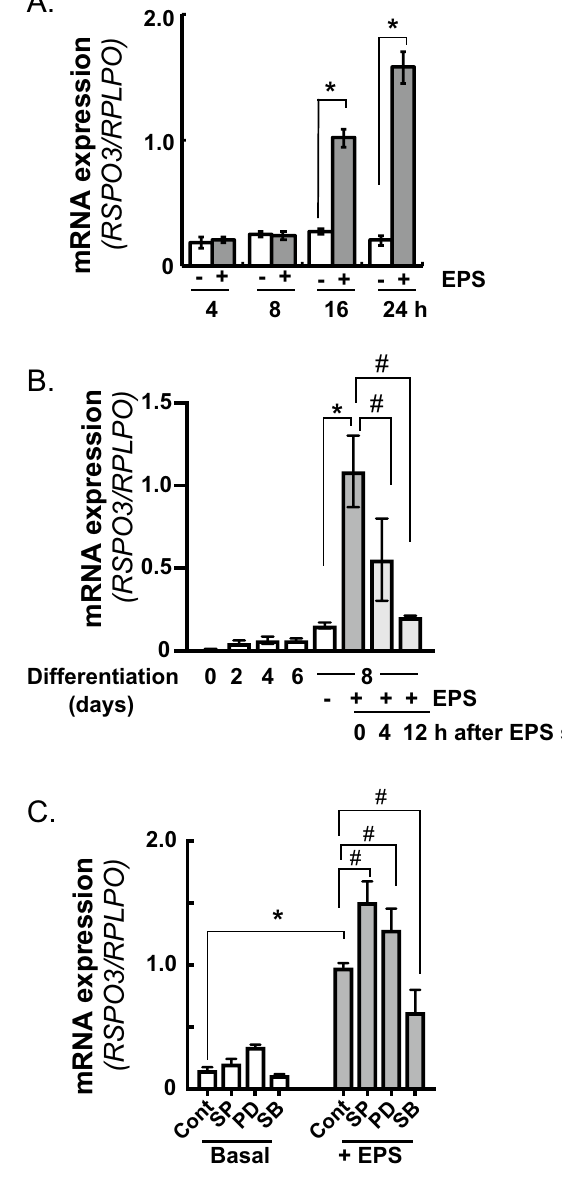
Figure 3. Human R-spondin 3 (RSPO3) mRNA expression during myogenesis and effects of MAPK inhibitors on EPS-induced RSPO3 upregulation. ( A ) Time-course of RSPO3 mRNA expression of differentiated human myotubes (day8) in response to the indicated duration of EPS (1 Hz, 4-ms, 20 V/25 mm) were evaluated by RT-PCR. Data normalized using RPLP0 transcript were averaged over 3 independent experiments (* P < 0.05). ( B ) RSPO3 mRNA levels during myogenesis on the indicated day and those of fully differentiated human myotubes (day 8) subjected to EPS (1 Hz, 4-ms, 20 V/25 mm) were evaluated by RT-PCR. Effects of EPS cessation on RSPO3 mRNA expression at the indicated time were also evaluated in fully differentiated human myotubes (day 8) after 24 h of EPS treatment. ( C ) EPS was applied in the presence or absence of SP-600129 (SP; 20 µM), PD-98056 (PD: 50 µM), or SB-203580 (SB; 5 µM), and RSPO3 mRNA expression levels were evaluated by RT-PCR. Data normalized using RPLP0 transcript were averaged over 3 independent experiments. Multi factor ANOVA with Tukey’s multiple comparison test was used for statistical analyses; the significance of the effect of EPS is denoted as * P < 0.05; the effects of time after EPS cessation vs. immediately (0 h) after EPS (B), or the effects of reagents compared to the control (with EPS) (C) are denoted as # <